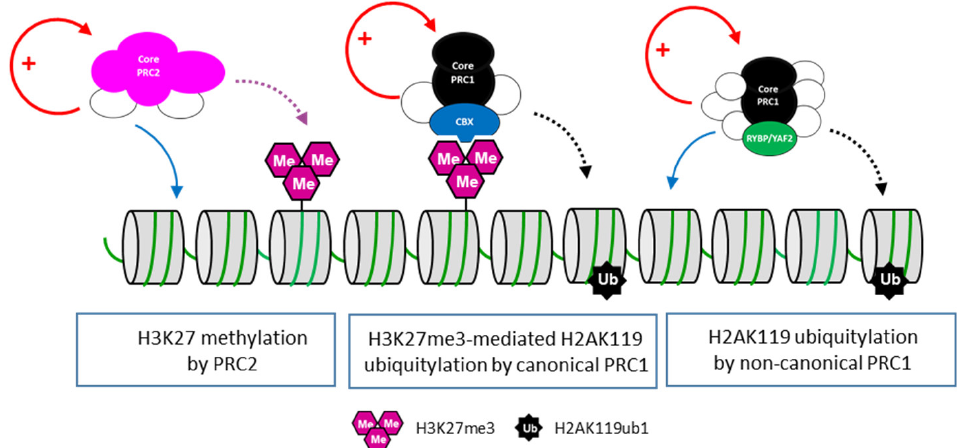
Figure 2. Deposition of the Polycomb-associated histone marks. Targeting of the PRC2 complex through the action of auxiliary proteins (white circles) leads to methylation at H3K27 (purple dashed arrow). This post-translational modification is recognized by the CBX subunit (blue) of the cPRC1 complex, which in turn ubiquitinylates H2AK119 (black dashed arrow). The ncPRC1 complexes containing RYBP/YAF2 (green) are recruited to chromatin, irrespective of H3K27me3, by the means of auxiliary subunits (blue arrow). Within all PRC complexes, some auxiliary proteins are involved in the stimulation of the catalytic activity (red arrows).